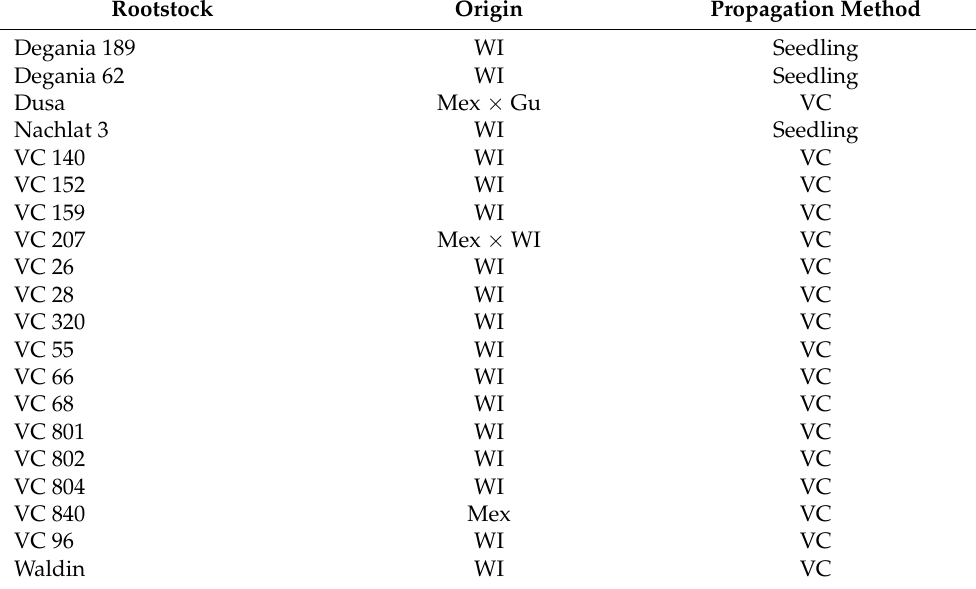
Table 1. Rootstocks evaluated in the experiment. Origin Propagation